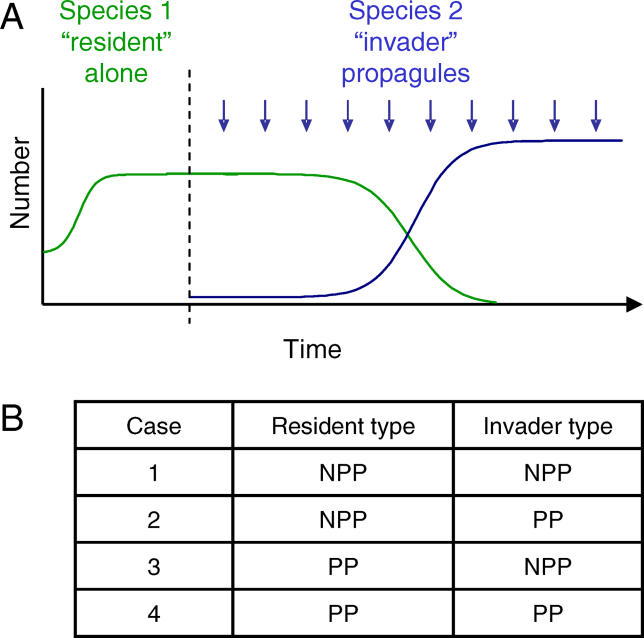
Design of Computational Model (IBM) Experiments(A) Schematic diagram of invasion experiments. Initially, a resident species populates the habitat with a finite initial density and is given a finite time period (dashed vertical line) in isolation sufficiently long to evolve an adaptive behavioral strategy. Thereafter individuals from the “invader” species are added to the habitat. In some cases, the resident species will repel invasion, with the invader species density never increasing. In others, as exemplified in the figure, the invader become established and displaces the resident.(B) Invasion experiments as in (A) were performed for all four combinations of residents and invaders as either NPP-consumers (cannot evolve plasticity) or PP-consumers (can evolve plasticity). Note the resident species evolves an adaptive strategy whether it is an NPP- or PP-resident species, the difference being that, unlike in the PP case, in the NPP case, the resident is constrained to find the behavior that optimizes fitness when that behavior must be the same in both environmental states (predator present and absent).